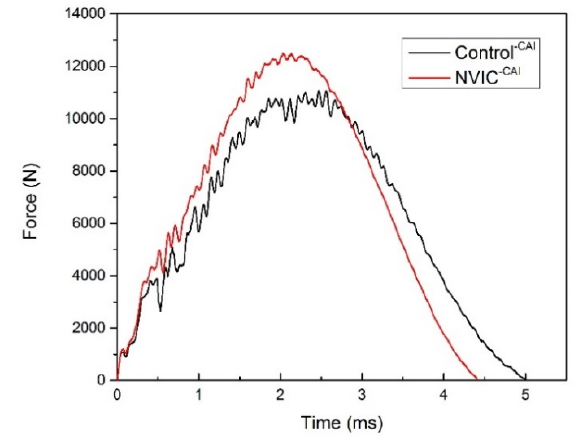
Figure 15. Time histories of the applied force during impact test.